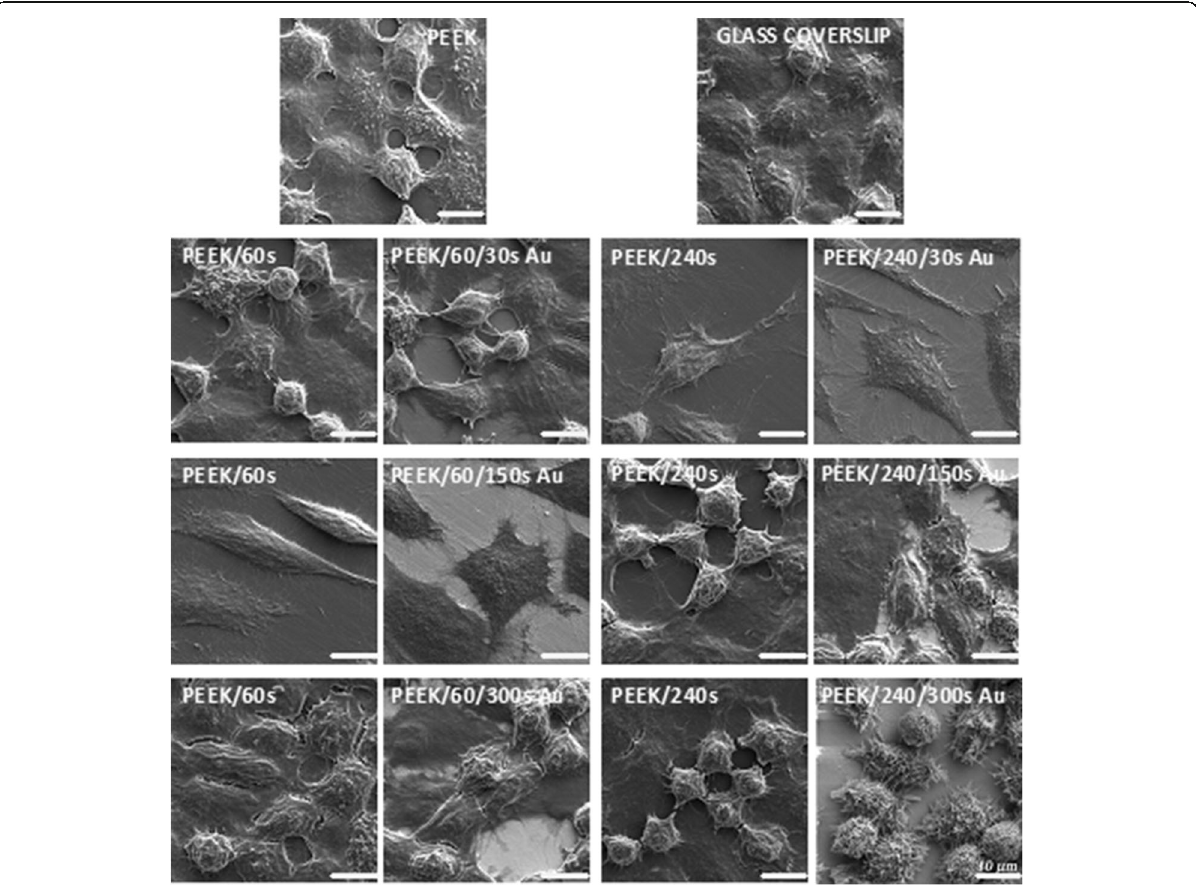
Fig. 4 SEM images of L929 cells cultivated for 72 h on pristine PEEK, PEEK treated by plasma (60 and 240 s), and their gold-coated parts sputtered for 30 and 300 s (microscopic glass coverslip served as a control). The scale bar corresponds to 10 μ